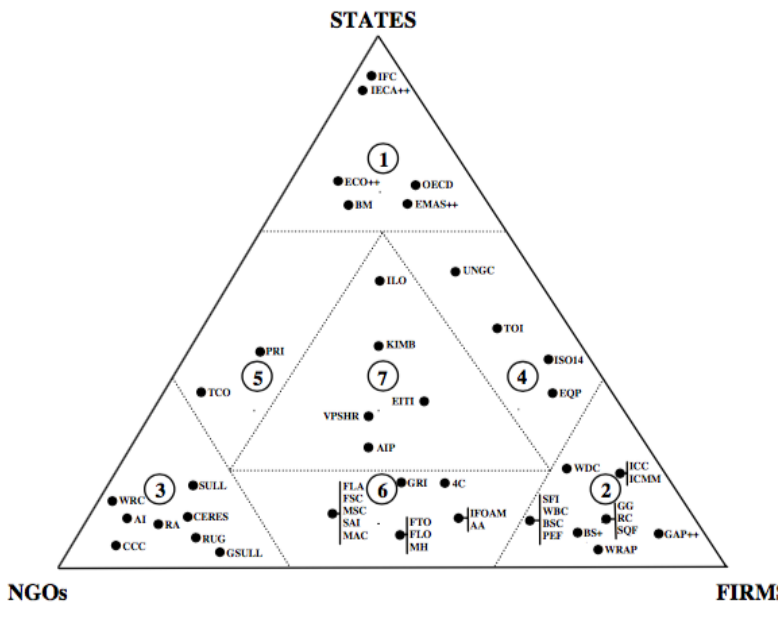
Figure 1: The Governance Triangle (Abbott and Snidal, 2009a). Reproduced with permission from the authors and the Vanderbilt Journal of Transnational